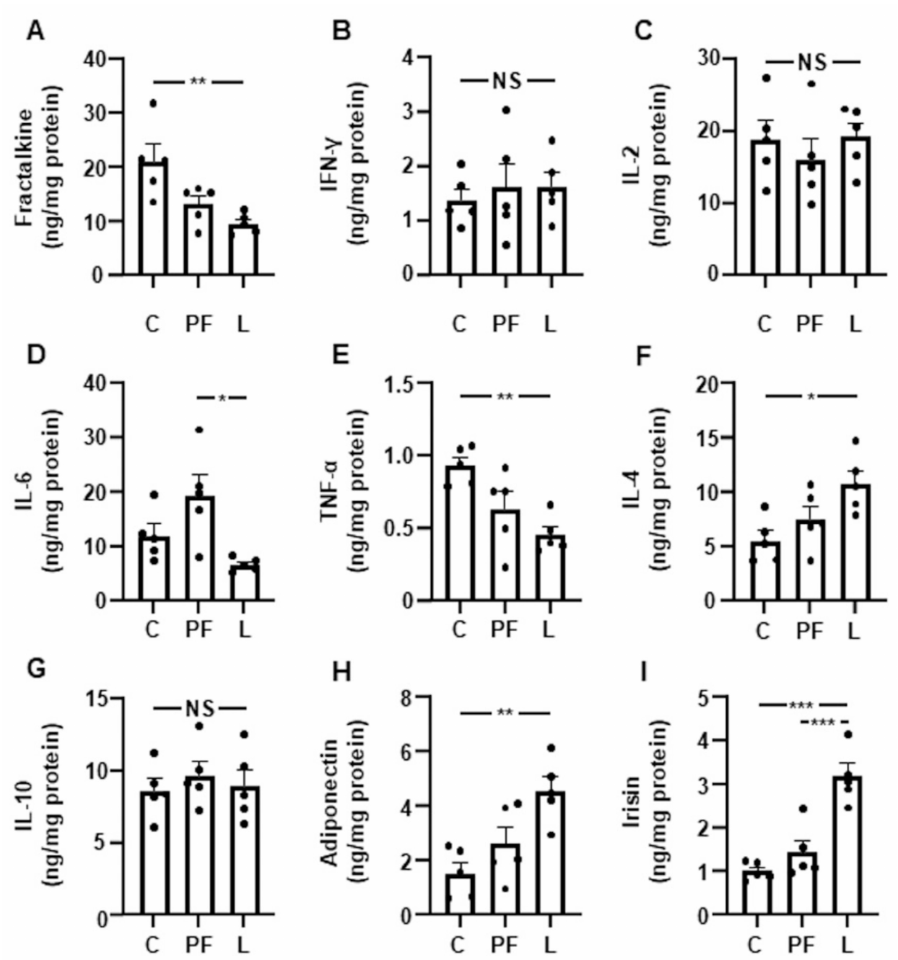
Figure 3. Effect of leptin on muscle cytokine levels. Fractalkine ( A ), interferon (IFN) γ ( B ), interleukin (IL)2 ( C ), IL-6 ( D ), tumor necrosis factor (TNF) α ( E ), IL-4 ( F ), IL-10 ( G ), adiponectin ( H ) and irisin ( I ) content in the gastrocnemius of control rats (C), pair-fed rats (PF) and rats receiving chronic intracerebroventricular leptin infusion (L). Data are presented as means ± SEMNS, non-significant. * p < 0.05, ** p < 0.01, *** p < 0.001; one-way ANOVA followed by Bonferroni’s test. Dots represent the individual